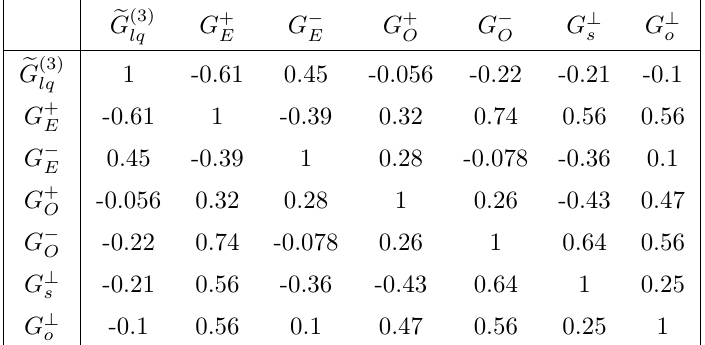
Table 9 . Correlation matrix for the linearized fit in the basis defined in section 2.4.